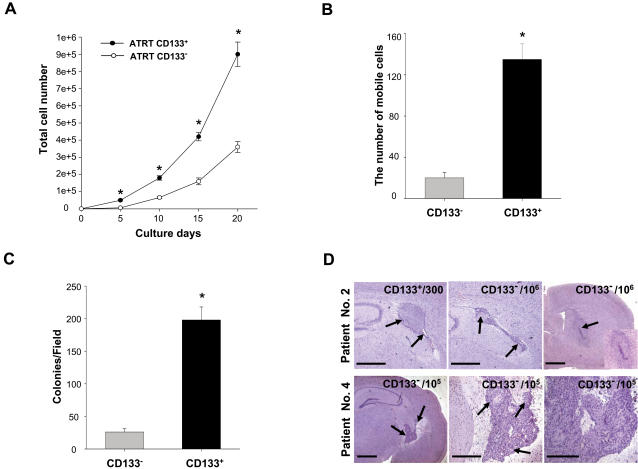
Cell growth rate, invasive ability, and tumor formation ability of CD133+/− AT/RT cells.The growth rate and tumorigenic ability of CD133+/− AT/RT cells were analyzed by using (A) MTT assay, (B) In vitro matrigel Transwell invasion assay, and (C) soft agar formation assay. *p<0.05 (D) The in vivo tumorigenic activity of CD133+/− AT/RT cells was assessed by injecting increasing numbers of cells into the brain stratum of SCID mice. Tumors develop with as few as 300 CD133+ AT/RT cells (Patient No. 2), whereas 105 CD133− (Patient No. 4) are needed to produce tumors. Bar: 150 m.